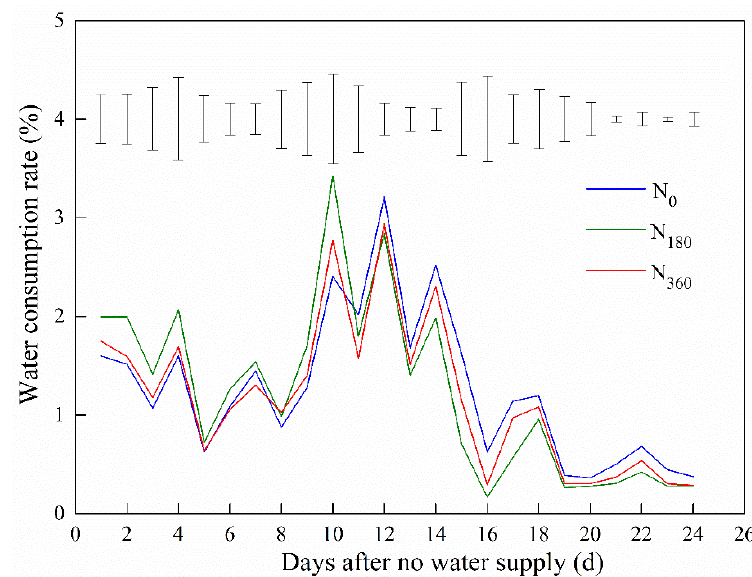
Figure 3. Water consumption rates of the maize field grown subjected to drought stress under different N levels. The vertical bars represent the least significant difference (LSD) at p = 0.05.